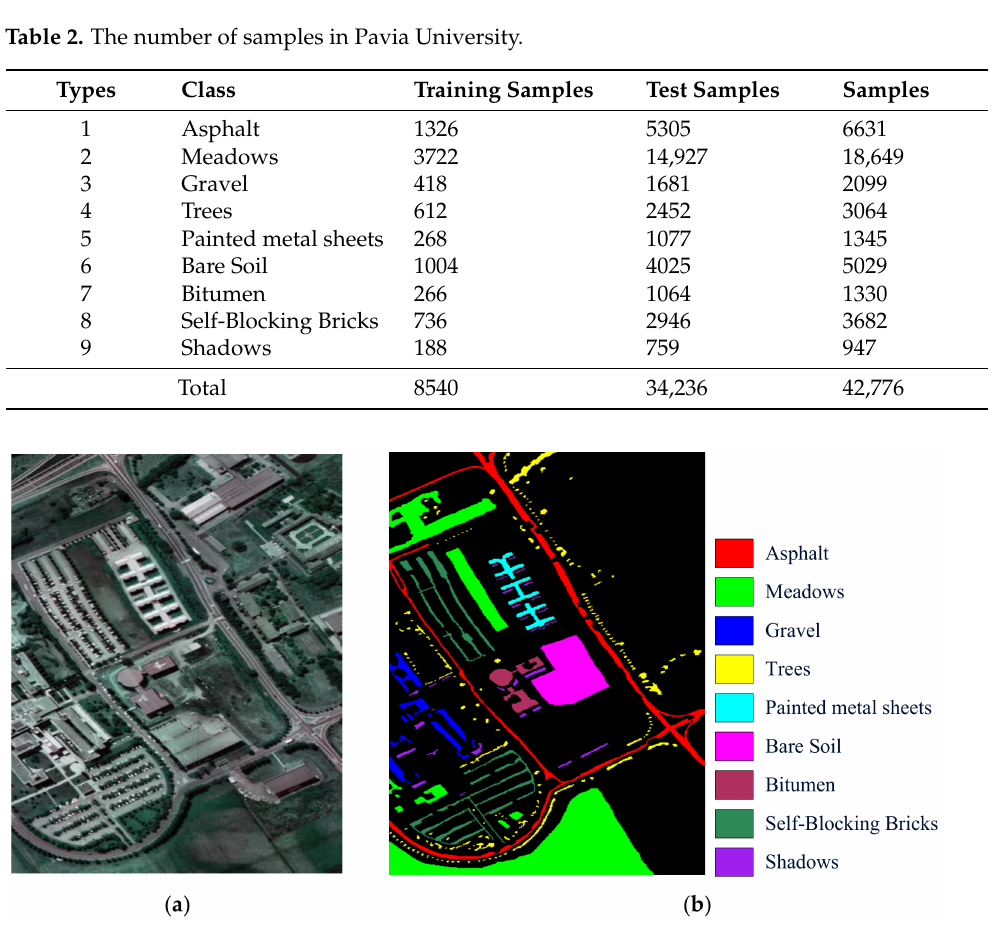
Figure 5. The HRSIs of Pavia University. ( a ) False color composite of HRSI. ( b ) Surface